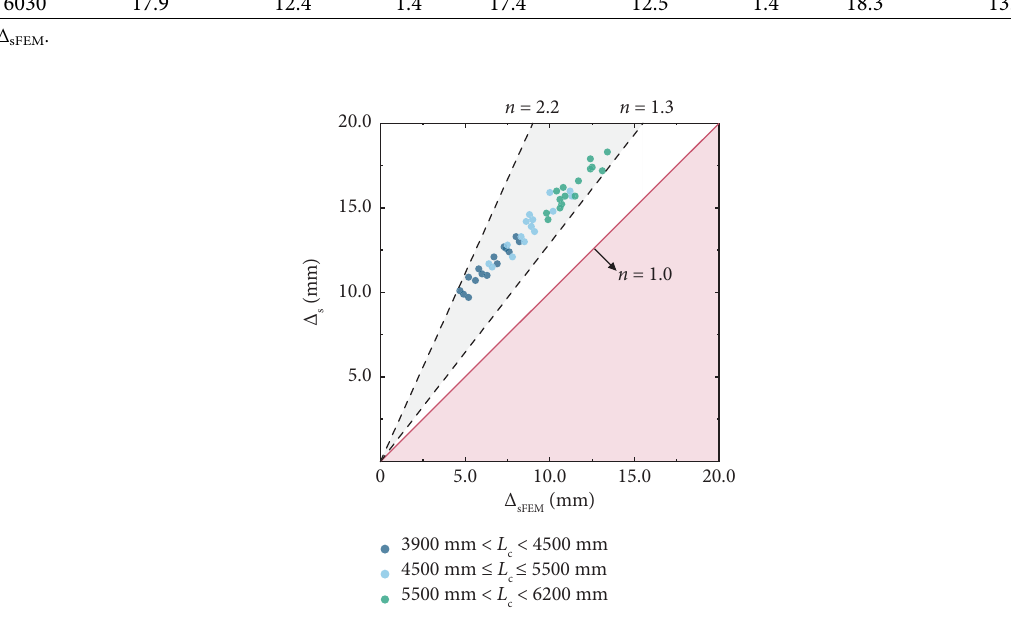
∆ s ) and the simulation results ( s FEM ).